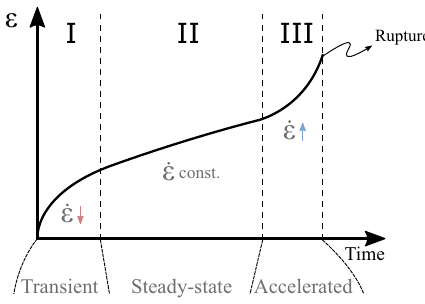
Figure 1. Creep deformation curve under constant external load.